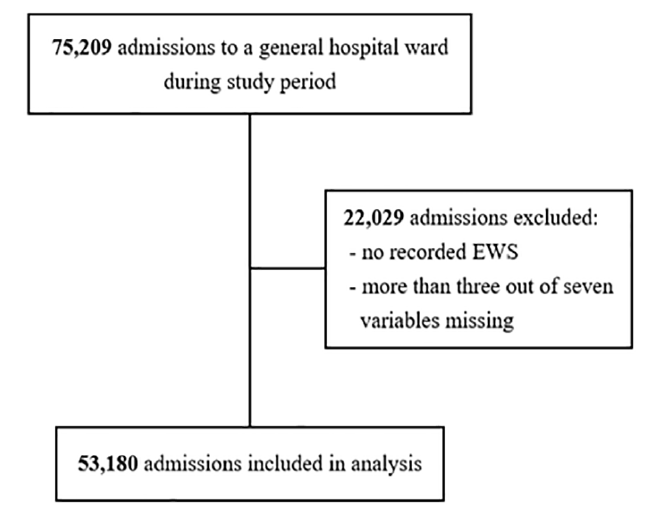
Figure 2. Flowchart of the study population.